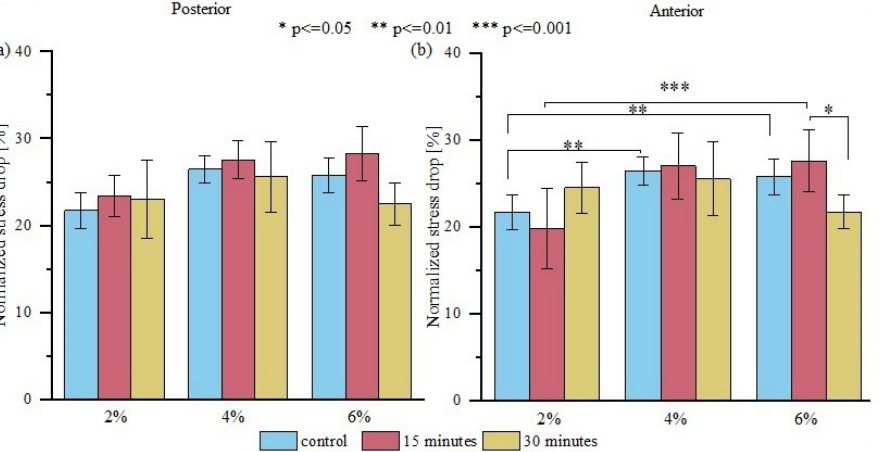
Figure 6. A comparison of normalized stress drop obtained for ( a ) posterior tendon fascicle bundles and ( b ) anterior tendon fascicle bundles for 2, 4, and 6% of initial strain. Values are shown for the control group and for samples dried for 15 and 30 min in open air. The viscoelastic properties of anterior samples were altered after drying; n =